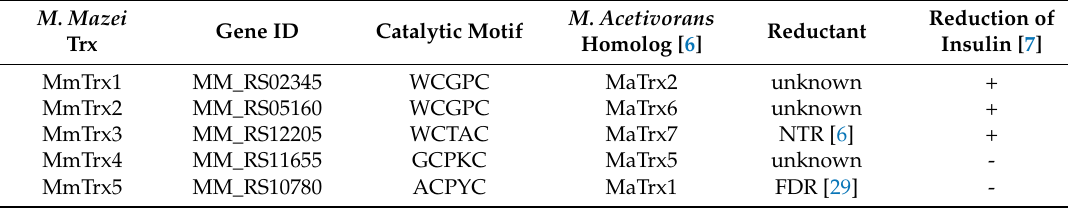
Table 1. The thioredoxin system composition in M. mazei and a comparison with the M. acetivorans system .